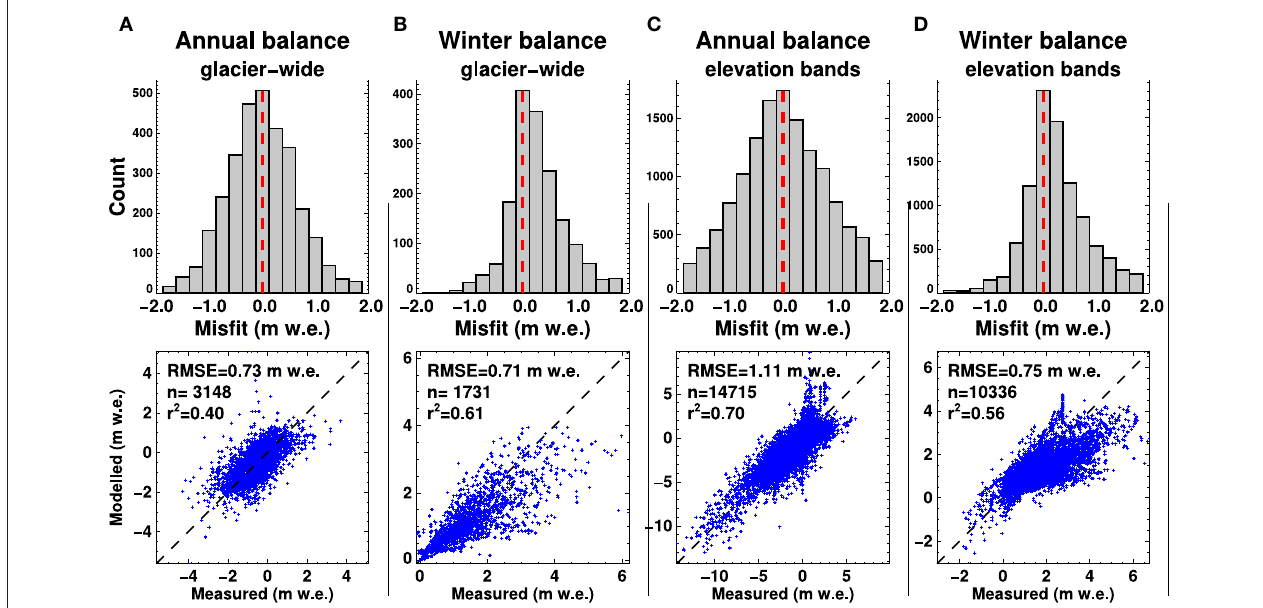
FIGURE 3 | Model validation results using mass balance observations between 1980 and 2012 (WGMS, 2012): Frequency of misfits in bins of 0.25m w.e. (observed minus modeled, upper panels) and scattergrams (lower panels) of modeled vs measured glacier-wide (A) annual balances, (B) winter balances, and (C) annual and (D) winter balances for individual elevation bands. Dashed red lines mark the zero misfit; the root-mean-square error (RMSE), the number of samples n , and the linear correlation coefficient r 2 are given in the lower panels.